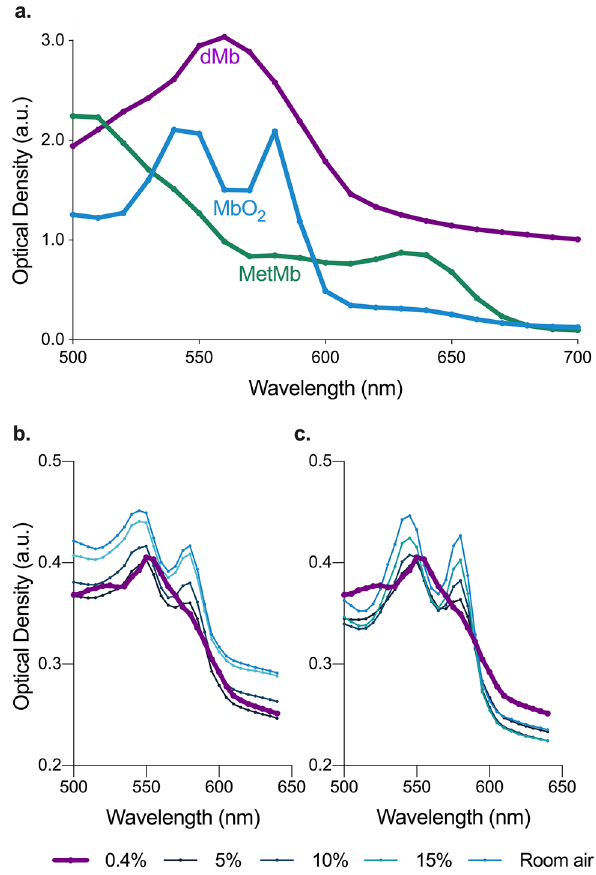
Figure 1. Light spectroscopy of myoglobin oxygenation: ( a ) Light spectroscopy verified the presence of oxygenated myoglobin (MbO 2 ), by the double peak spectrum (blue) in comparison to deoxygenated myoglobin (dMb, purple) and the untreated stock-solution of equine methyl-Mb (metMb, green). ( b ) Light spectroscopy further showed the functional capacity of MbO 2 to desaturate by reducing oxygen concentration from room air to 0.4%, and then its ability to re-oxygenate with the increase in oxygen content ( c ). Image prepared using Graphpad Prism v 8.0 (www. graph pad.